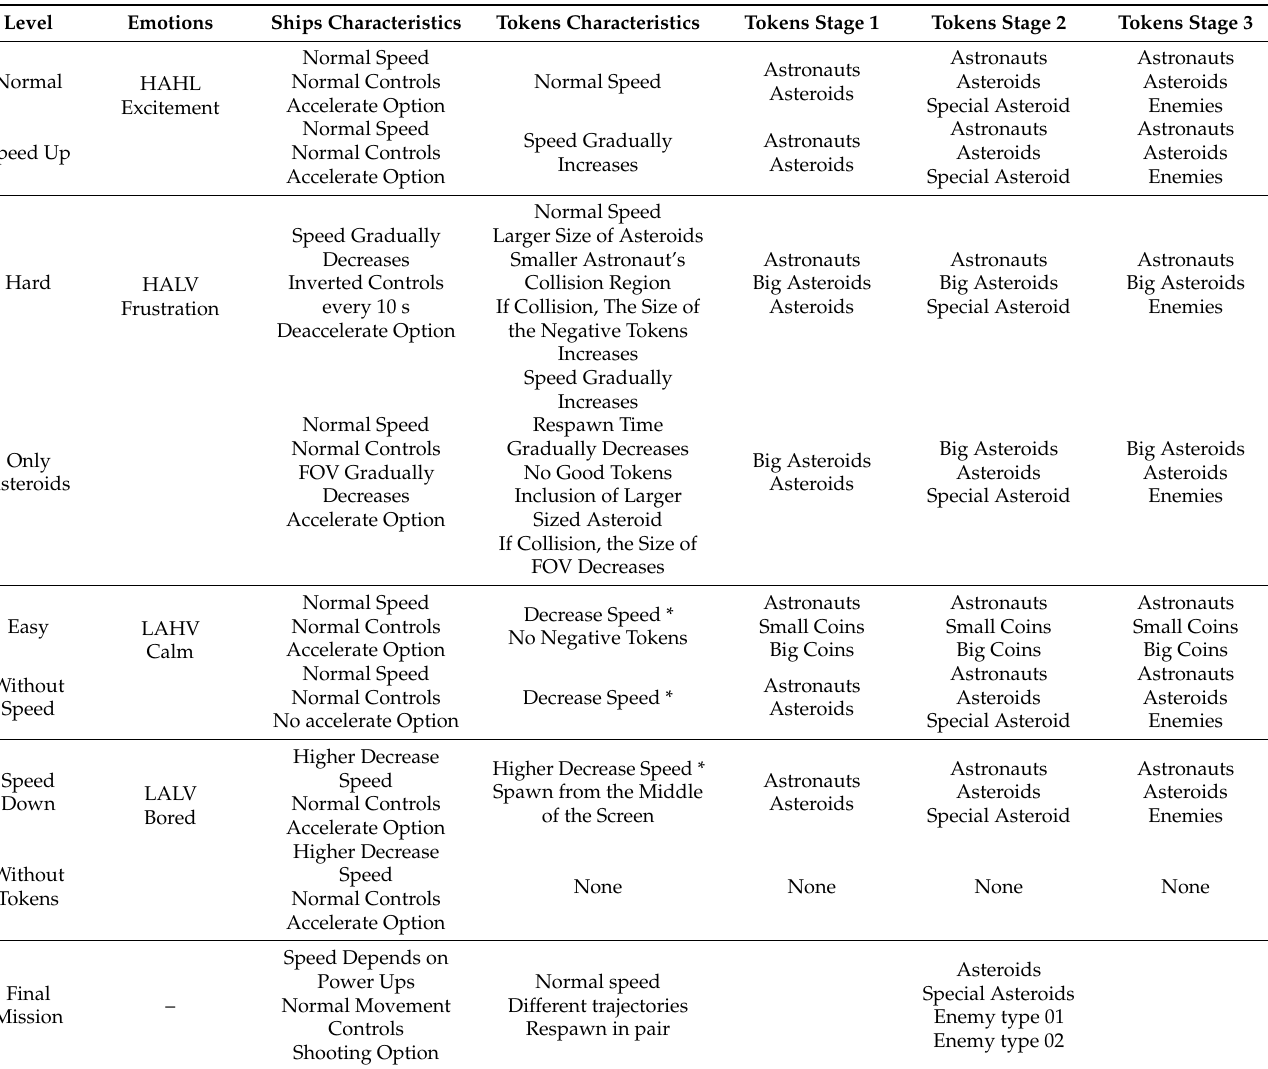
Table A1. Level characteristics (* compared to normal